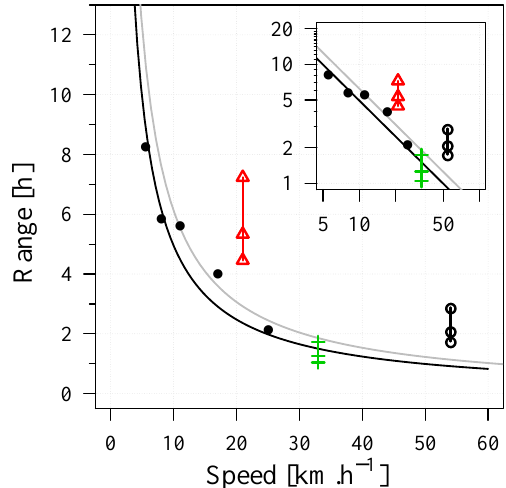
Fig. 17. Nonlinear relation between the advection speed and the threshold range for a catchment area of 4900km 2 . Black filled cir- cles represent five synthetic circular-shaped rainfall cells. Black line delineates Eq. (10). Black open circle, red triangle and green plus show three real-world rainfall events (see Fig. 14) with the values of the ranges for 100%, 90% and 80% (from top to bottom) of the corresponding partial sills. Grey line delineates the fitted nonlinear relation for synthetic rainfall cells with double diameter. The iden- tical figure with logarithmic axes is given in the